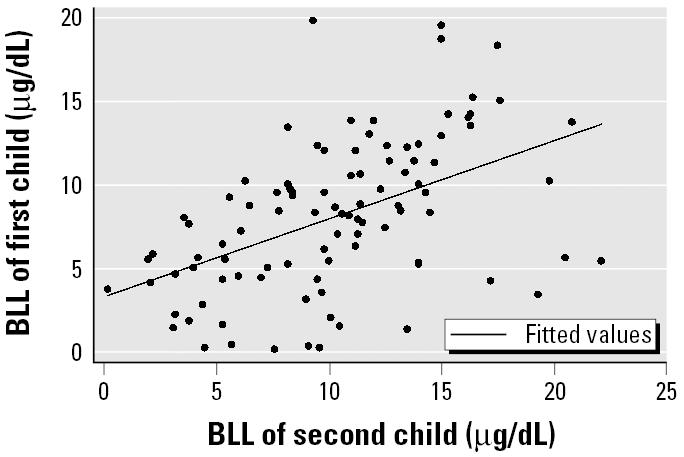
Scatter plot representing correlation in BLLs of children with siblings. Six children with BLLs ≥ 25 μg/dL were excluded to obtain a better representation on the graph; however, the graph was similar if the six children were included. Correlation coefficient = 0.48 (p < 0.0001); n for the correlation coefficient is 103 (not 105) because two children had two siblings in the cohort.